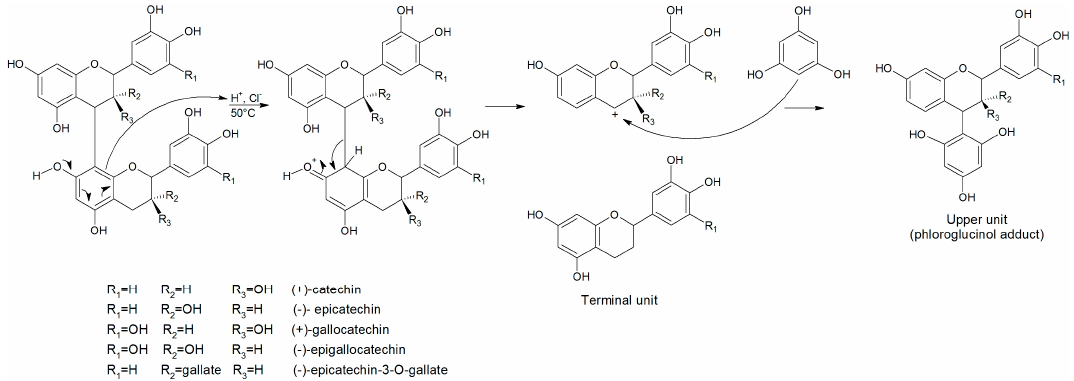
(C term ), epicatechin (EC term ), gallocatechin (GC term ), epigallocatechin (EGC term ) and epicatechin gallate (ECG term ) and phloroglucinol adducts of upper units of catechin (C up ), epicatechin (EC up ), epigallocatechin (EGC up ), and epicatechin gallate (ECG up ).